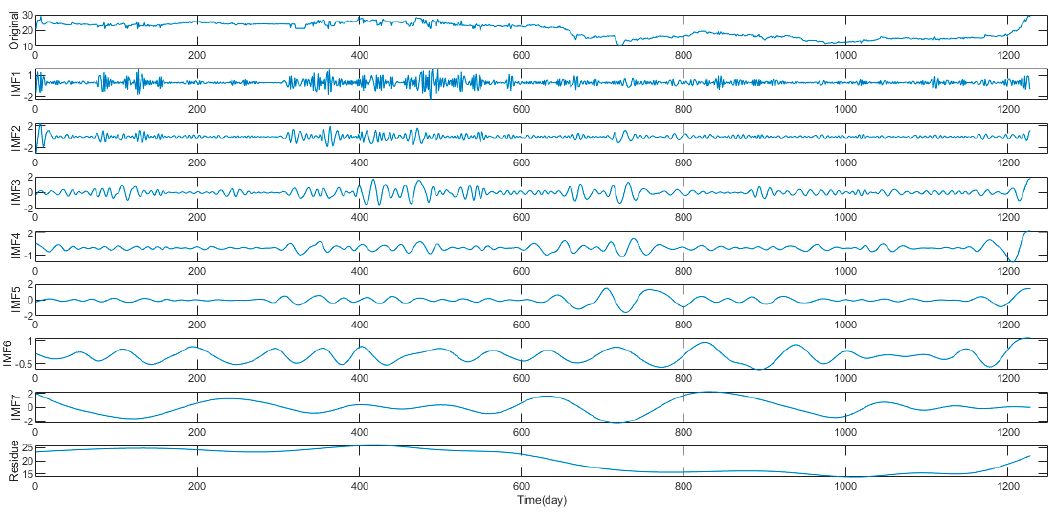
Figure 5. The results of the Hubei carbon price decomposed by ESMD.